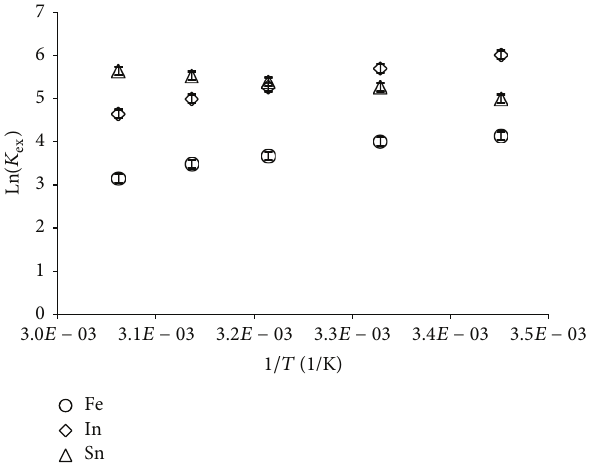
Figure 9: The effect of temperature on the extraction equilibrium of Fe(III), In(III), and Sn(IV). The aqueous phase was 1M H 2 SO 4 and the organic phase was 0.1M D2EHPA/kerosene, 𝜃 = 1 .